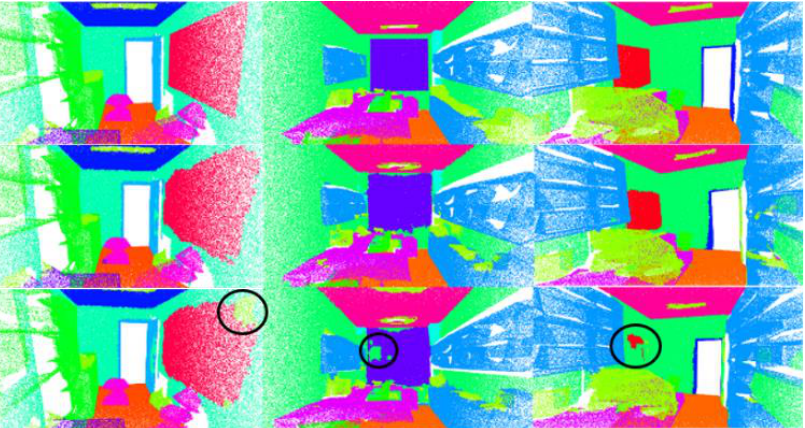
Figure 13. Visualization results. First row is the ground truth. Second row shows the results when using cross-skip selection. The third row shows the results when not using cross-skip